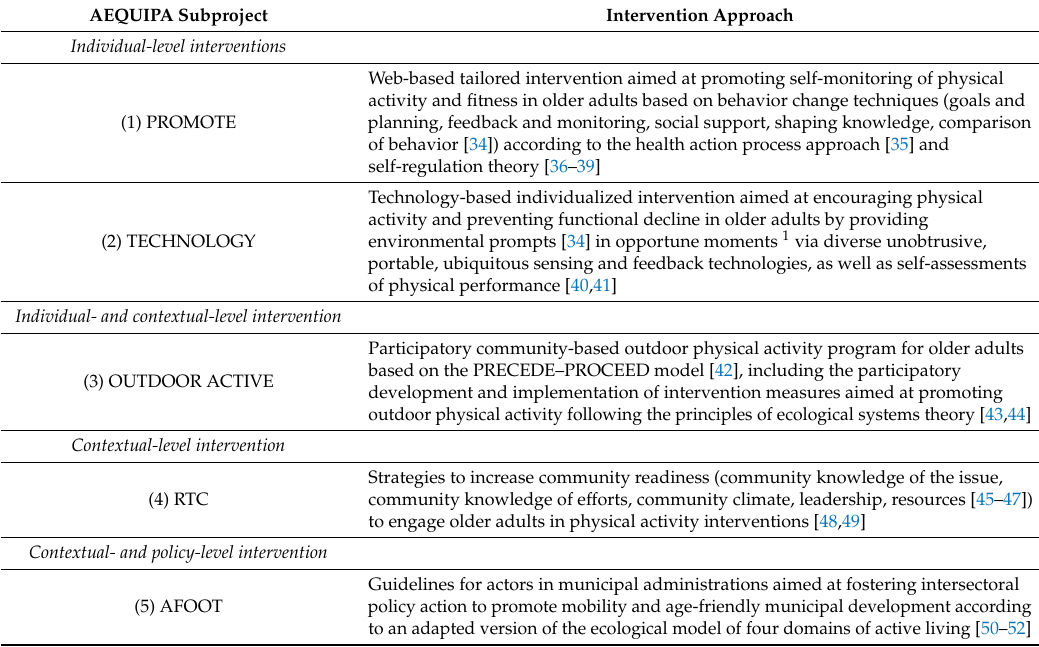
Table 1. The five physical activity interventions implemented within